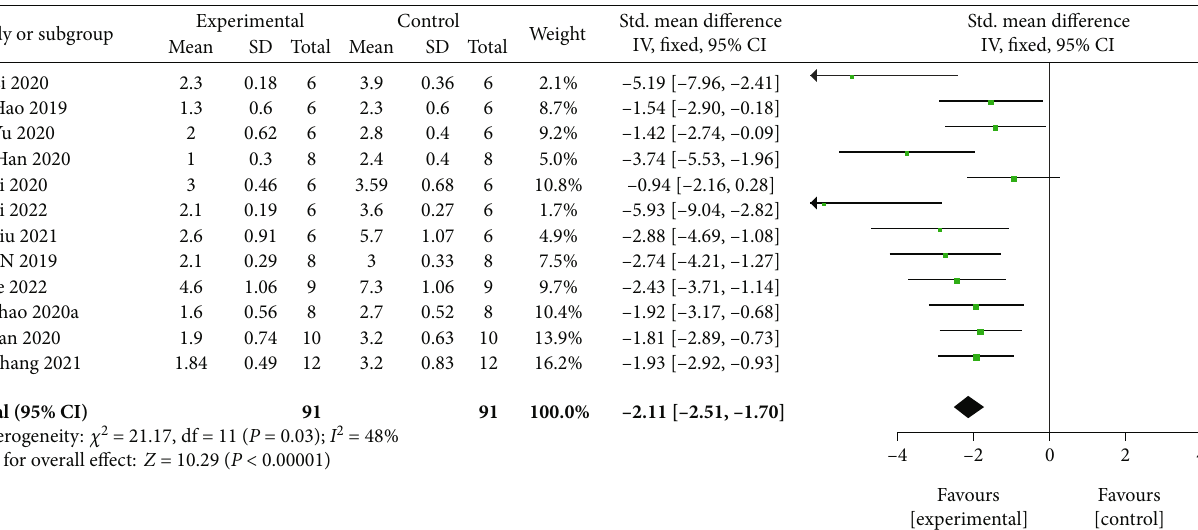
Figure 4: The forest plot: e ff ects of MSCs-derived sEVs for decreasing the neurological impairment score compared with control group.